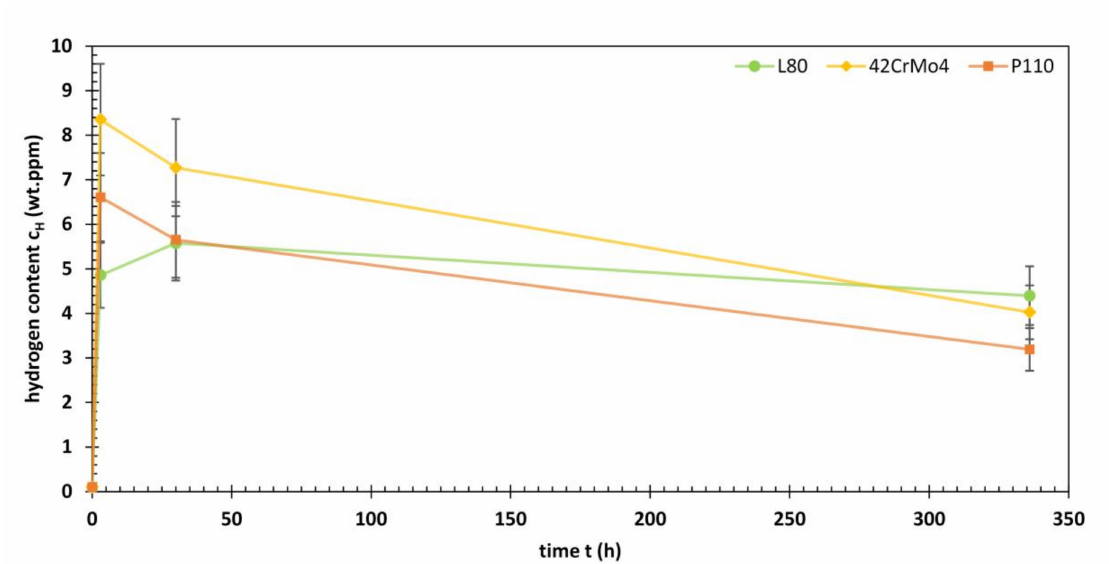
Figure 8. Hydrogen content of L80, 42CrMo4 and P110 after 3, 30 and 336 h of ambient pressure testing in an acidified H 2 S-saturated aqueous brine solution with 5.0 wt.% NaCl and 0.5 wt.% CH 3 COOH at room temperature (NACE Solution